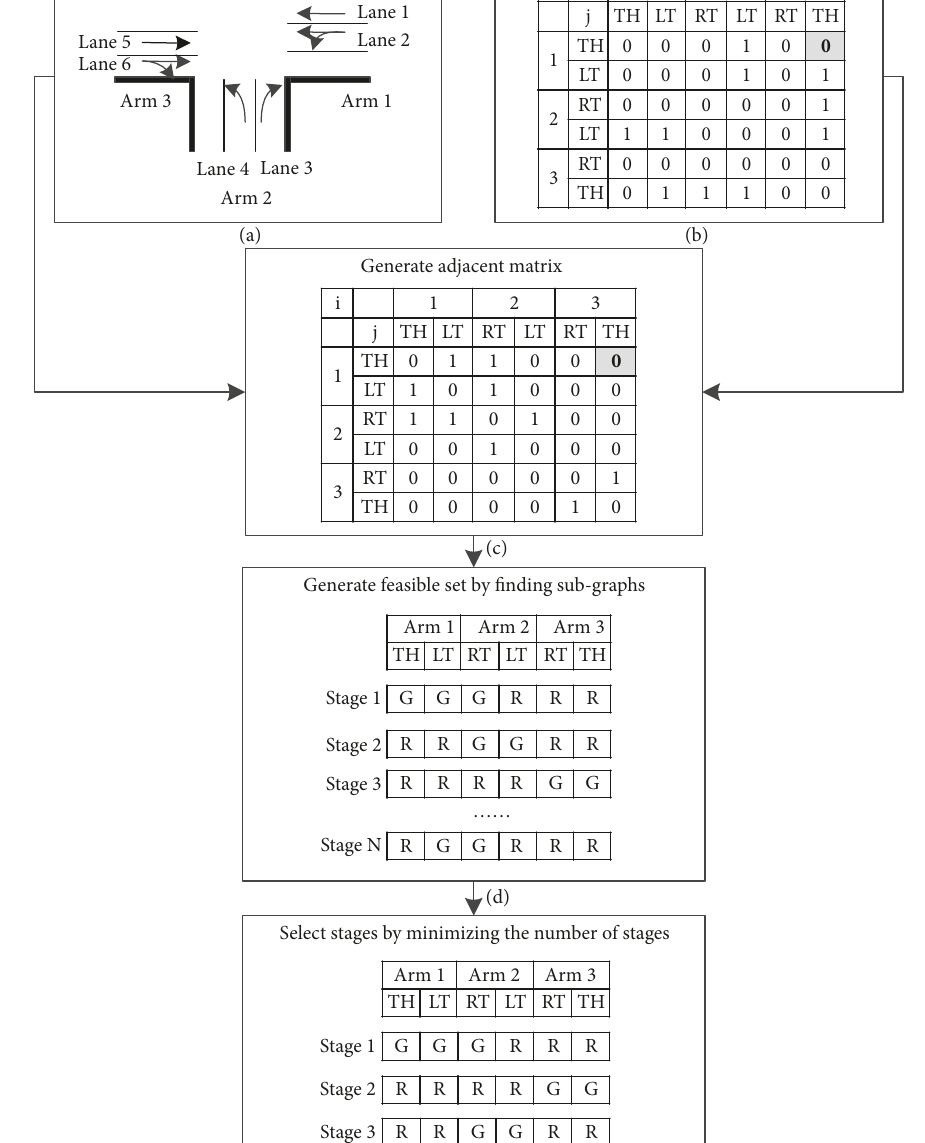
each stage is shorter than the distance of nonsequential stages sharing the same